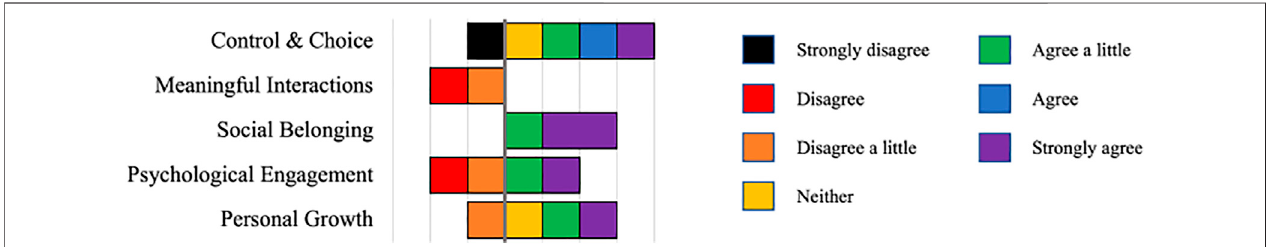
FIGURE3| Participants ’ responsestoSelf-reportedExperiencesofActivitySettingsscale.DataforparticipantC5isnotincluded,astheyhadminimalparticipation in the study (see Table 1 ).